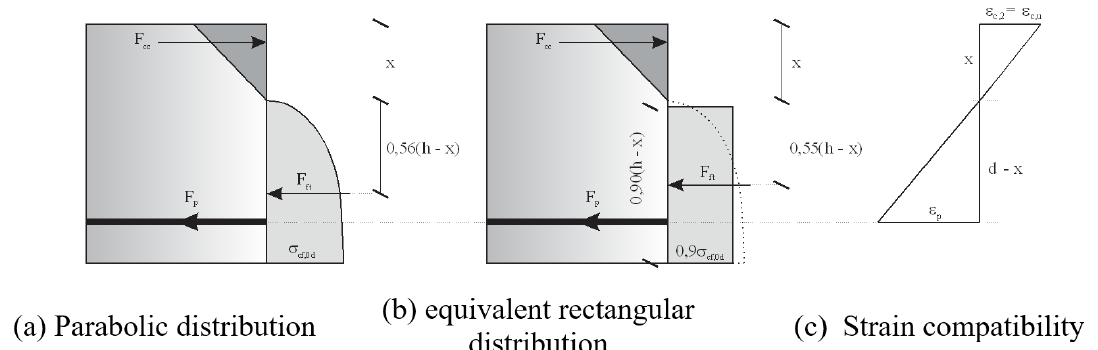
Figure 1. Stress distribution (a and b) and strain (c) for a rectangular cross-section (Fehling et al.